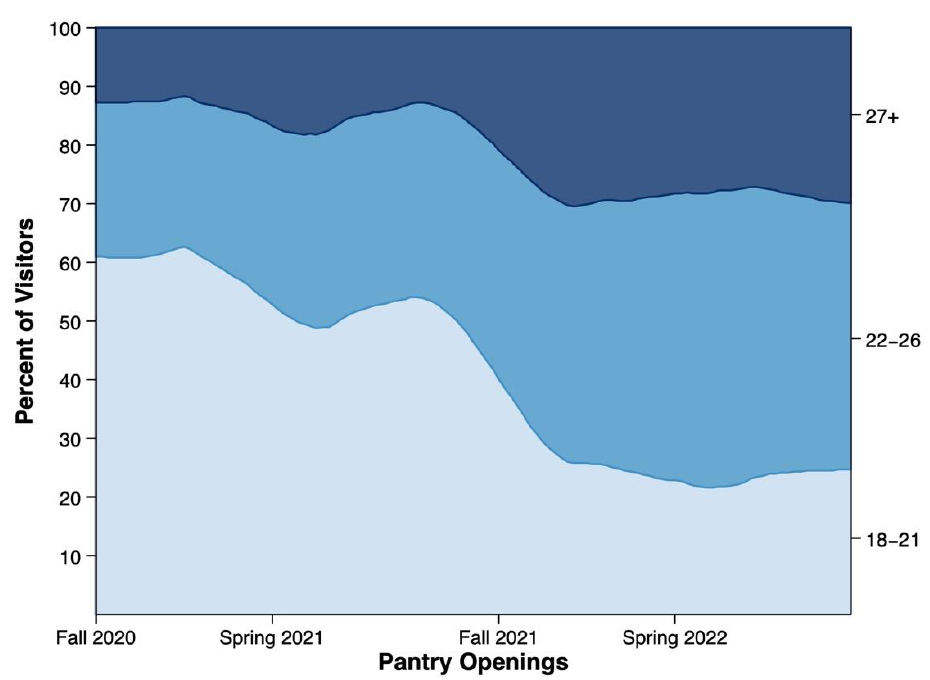
Figure 1. This graphic shows the percentage of students per opening from August 2020 through May 2022 with campus food pantry users grouped by age from Link2Feed data ( n = 579).